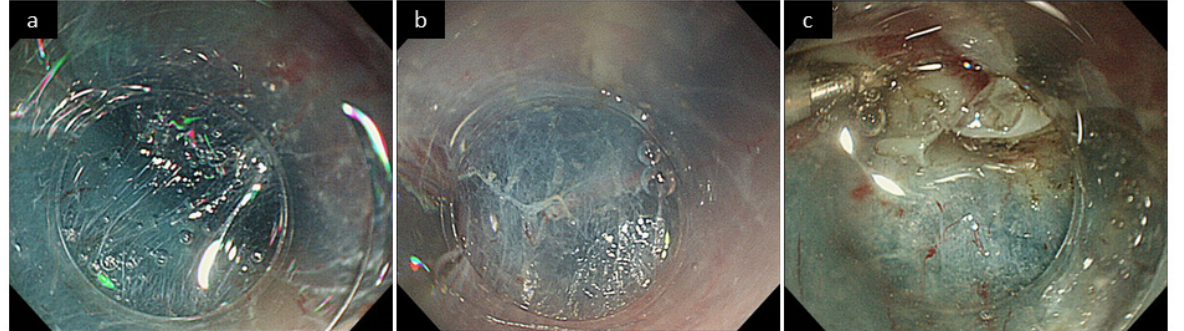
Figure 1. Evaluation criteria for endoscopic F score. ( a ) None or mild fibrosis (eF0). The submucosa is not whitish, and submucosa is sufficiently elevated by local injection. ( b ) Moderate fibrosis e(F1). The submucosa looks slightly white, but the submucosal elevation is possible. ( c ) Severe fibrosis (eF2). The submucosa looks highly white, and submucosal elevation is inadequate.